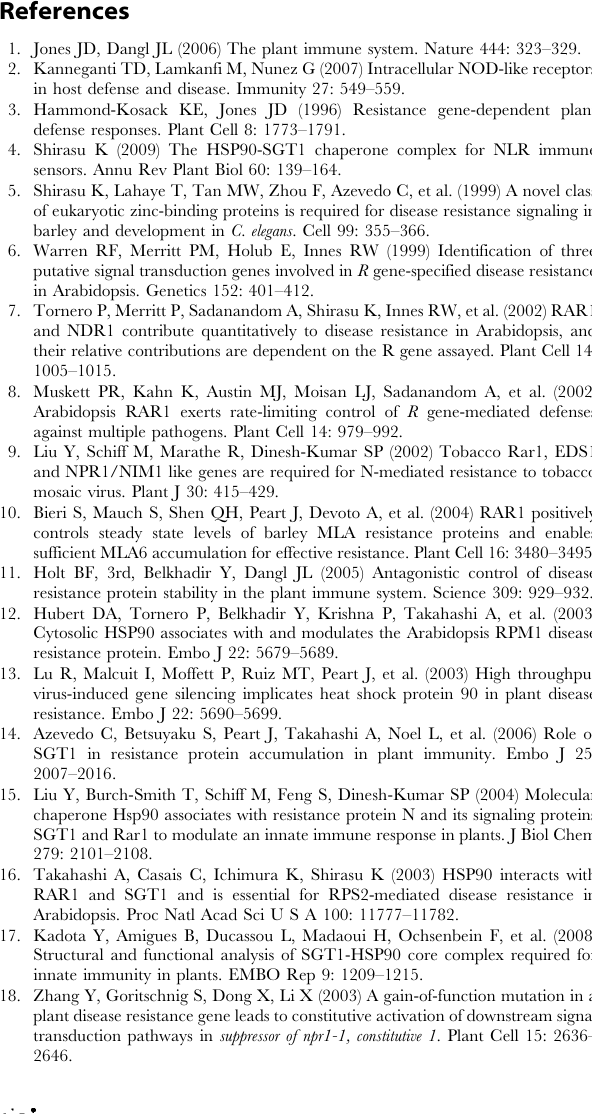
Figure S9 Location of the T-DNA insertion in sgt1a-3 (A) and real-time RT-PCR analysis of SGT1a expression in wild type (Col- 0) and sgt1a-3 (B). Primers used for the PCR analysis are indicated in (A). Error bars represent standard deviation from three